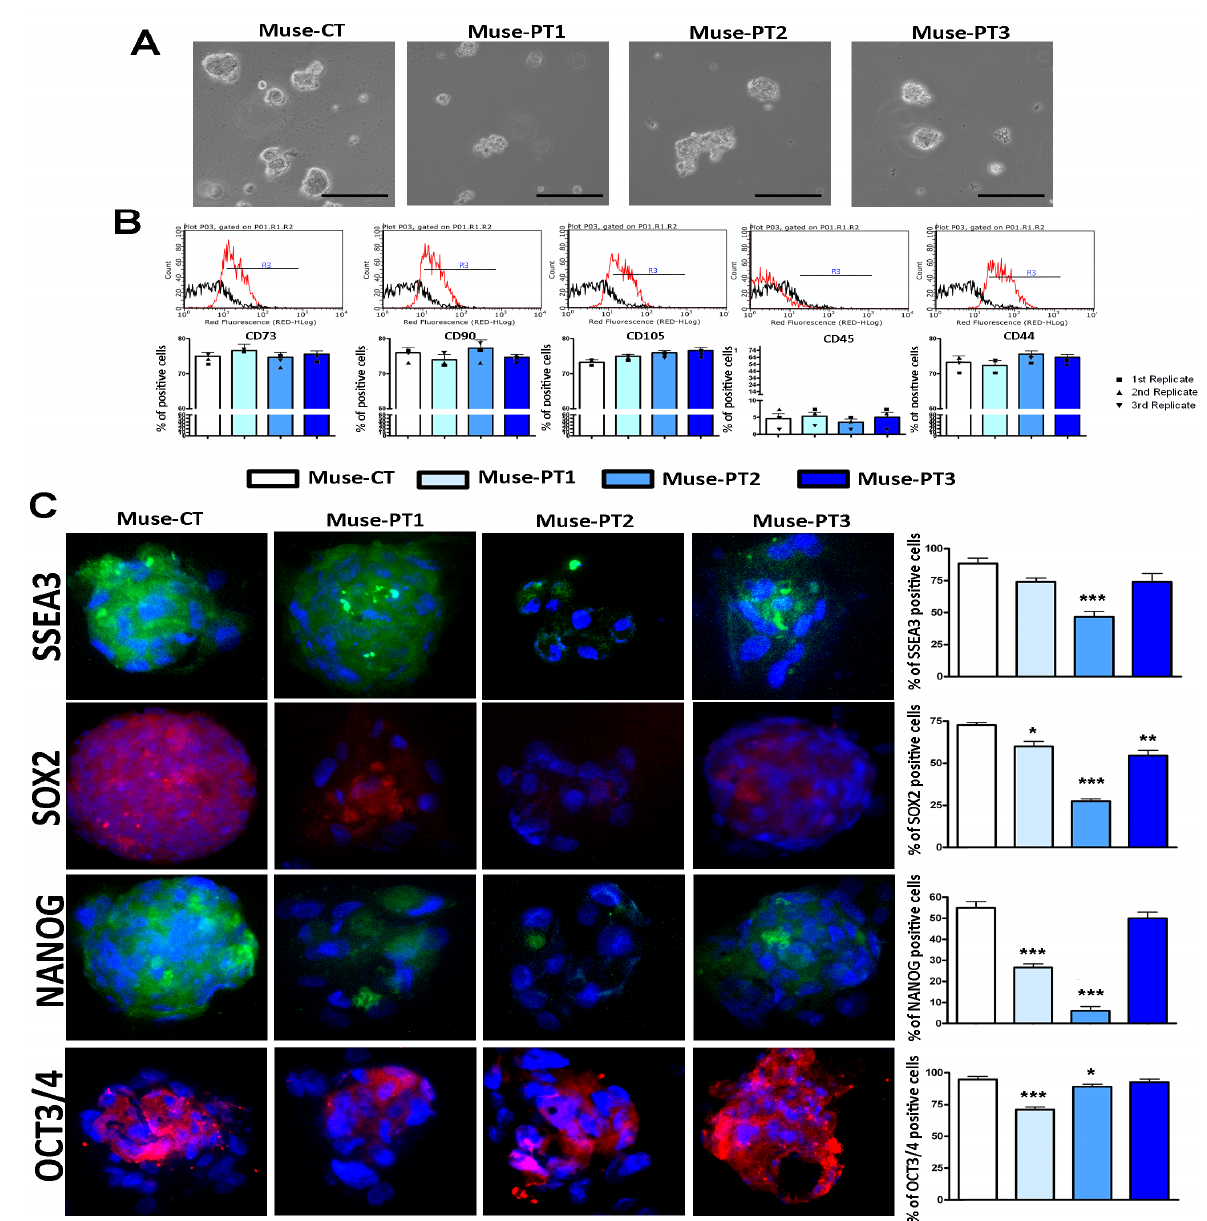
Figure 1. Markers of Muse stem cells isolated from patients’ fibroblasts . Panel ( A ): Micrographs showing the typical morphology of Muse stem cells grown in suspension. The black bar corresponds to 100 μ m. Panel ( B ): Representative flow cytometry plots of CD73, CD90, CD105, CD45, and CD44 on Muse cells isolated from healthy donors and patients. The histograms indicate the percentage of positive cells for every analyzed marker. Panel ( C ): Representative images of immunocytochemistry analysis to detect SSEA3 (i.e., green), SOX2 (i.e., red), NANOG (i.e., green), and OCT3/4 (i.e., red) in Muse stem cells (200× magnification). Cell nuclei were identified with DAPI (i.e., blue). The graphs on the right indicate the percentages of positive cells in the different samples. For all experiments, the symbols *** (i.e., p < 0.001), ** (i.e., p < 0.01), and * (i.e., p < 0.05) indicate statistical significance between the healthy control and the patients’ samples. For every sample, three biological replicates were performed, and data are reported with SDs.